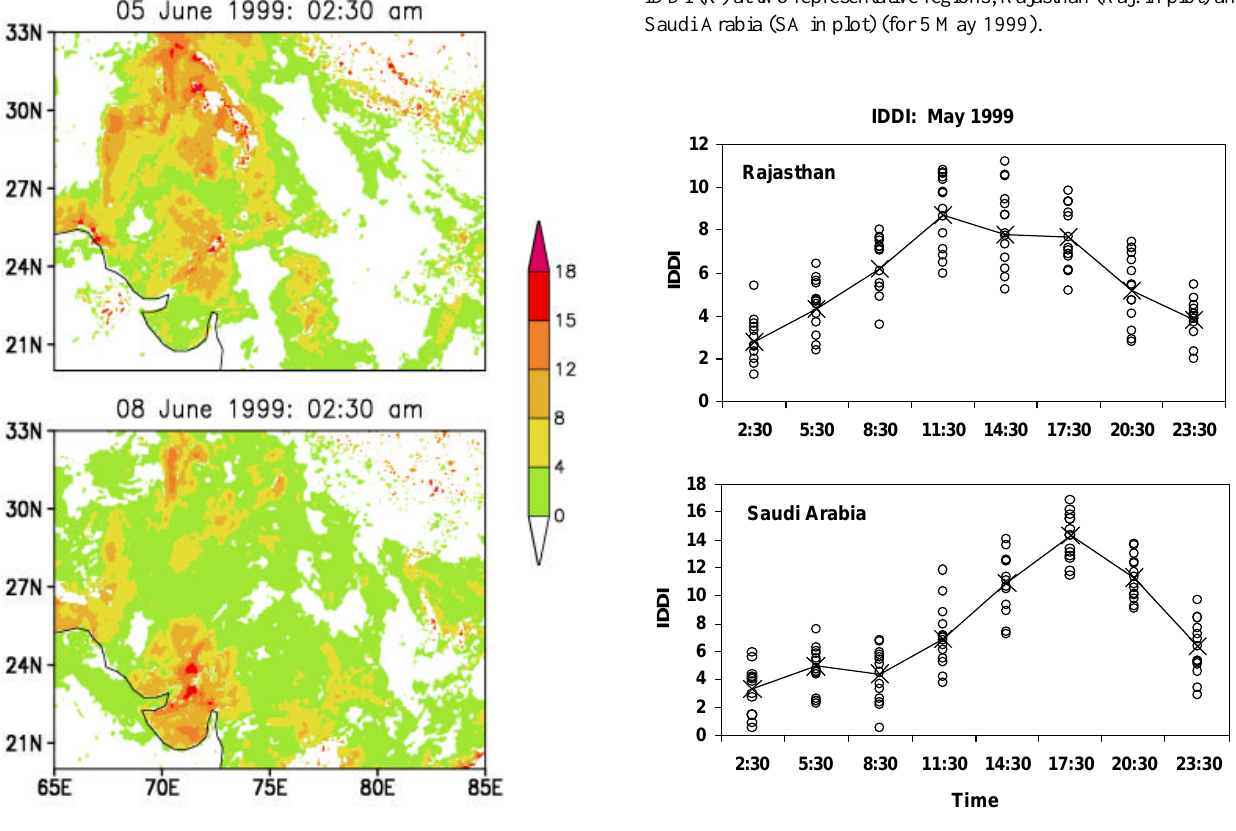
Fig. 18. Diurnal variation of IDDI (K) for May